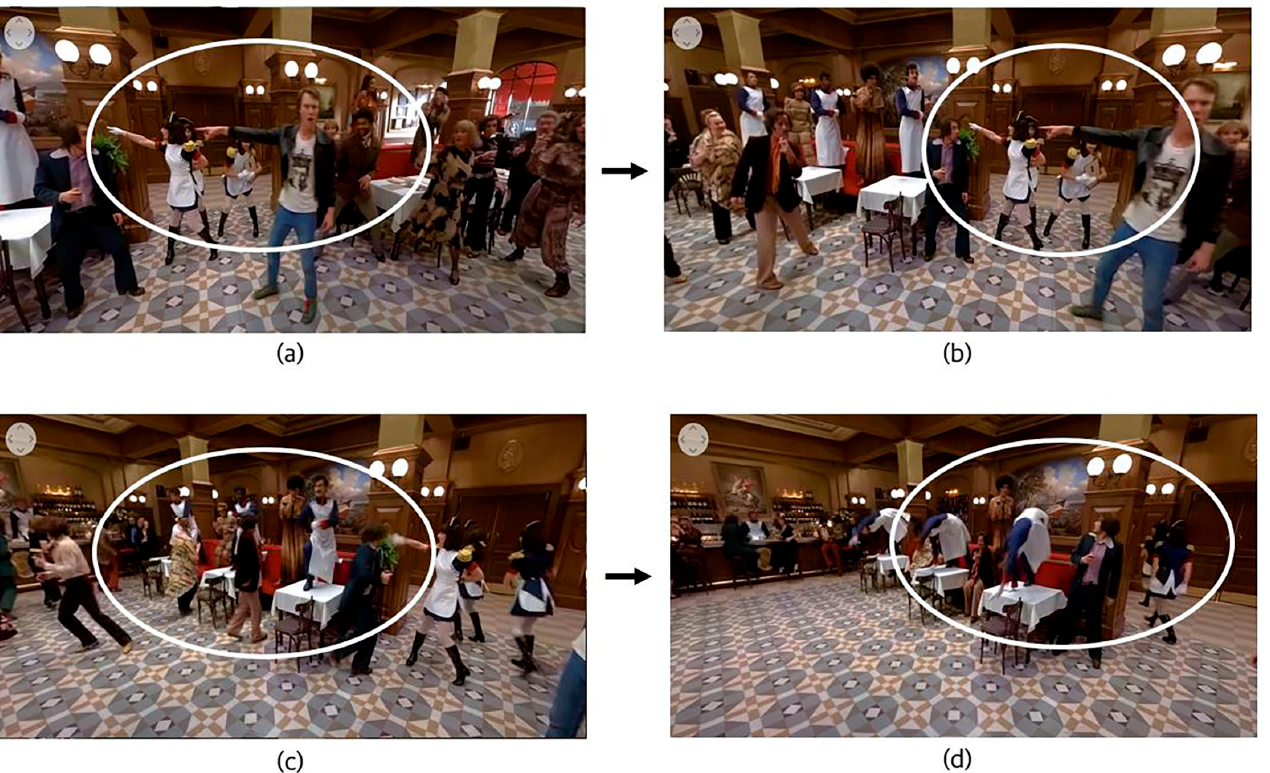
Figure 3. Directed Case 1 using “Hand gesture” (video No. 24). ( a ) The marked objects are ges- tured in the left direction, ( b ) The user’s attention moves to the left along with the objects’ gesture, ( c ) The user can watch other objects, ( d ) The user can see the marked objects are choreographed in the position intended by the director.